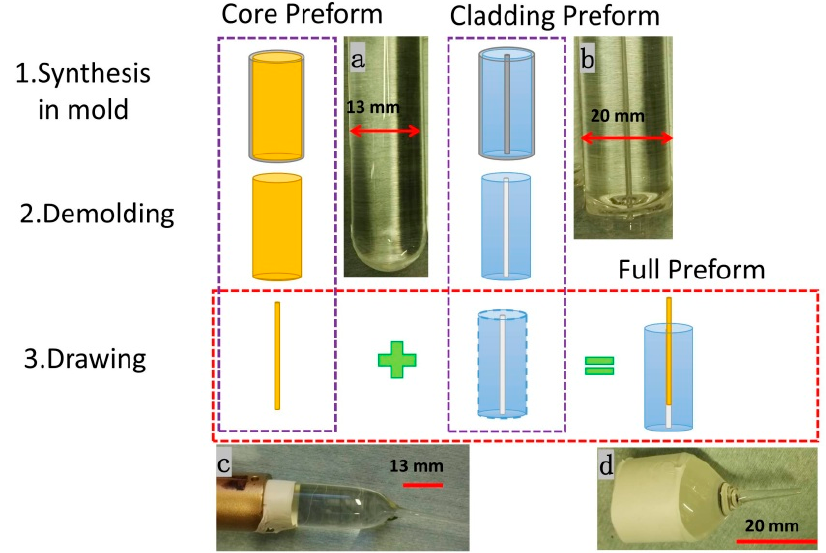
Figure 1. Preparation process of the polymer optical fiber (POF) preform; Subfigure ( a – d ) are the photos of the core preform, cladding preform with a hole, the drawn core cane, and the full preform.